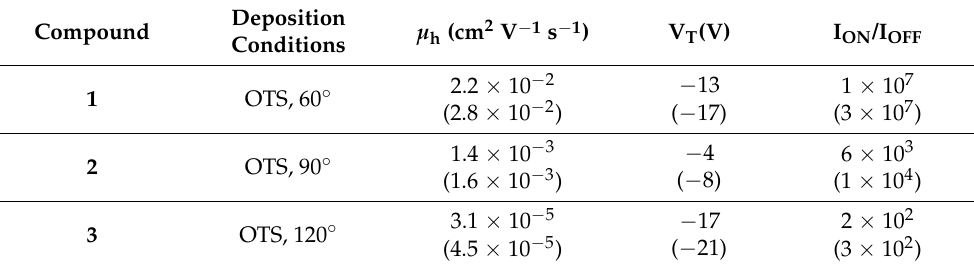
Figure 7. TFT transfer ( top ) and output ( bottom ) characteristics of triindoles 1 ( a ), 2 ( b ) and 3 ( c ). The transfer characteristics were measured at a constant source – drain voltage of − 80 V. The output curves were measured at gate voltages varying from 20 to − 80 V in intervals of 10 V. Table 2. OFET electrical data for vapor deposited film of 1 – 3 semiconductors measured at ambient conditions. Average and the best (in parenthesis) values are